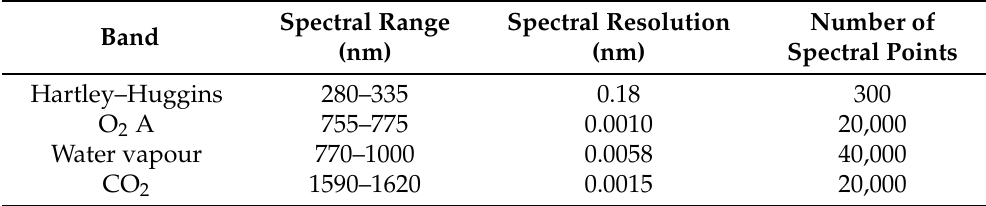
Table 1. Spectral ranges, resolutions and number of spectral points for the absorption bands used in this